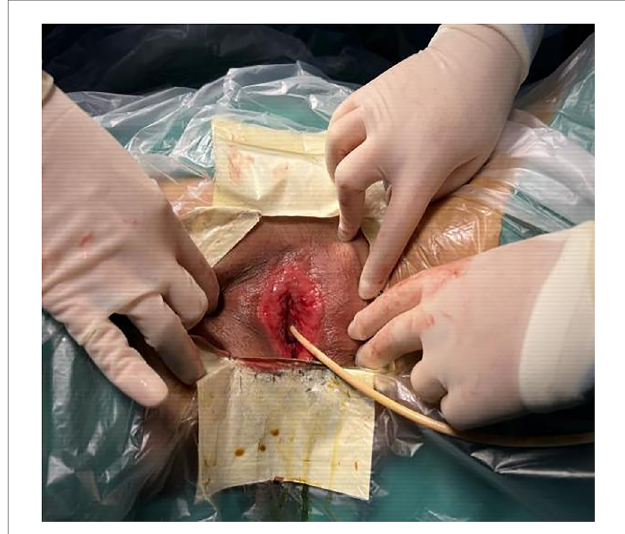
FIGURE 2 The skin of the adhesion separation wound was thin, with little blood oozing.